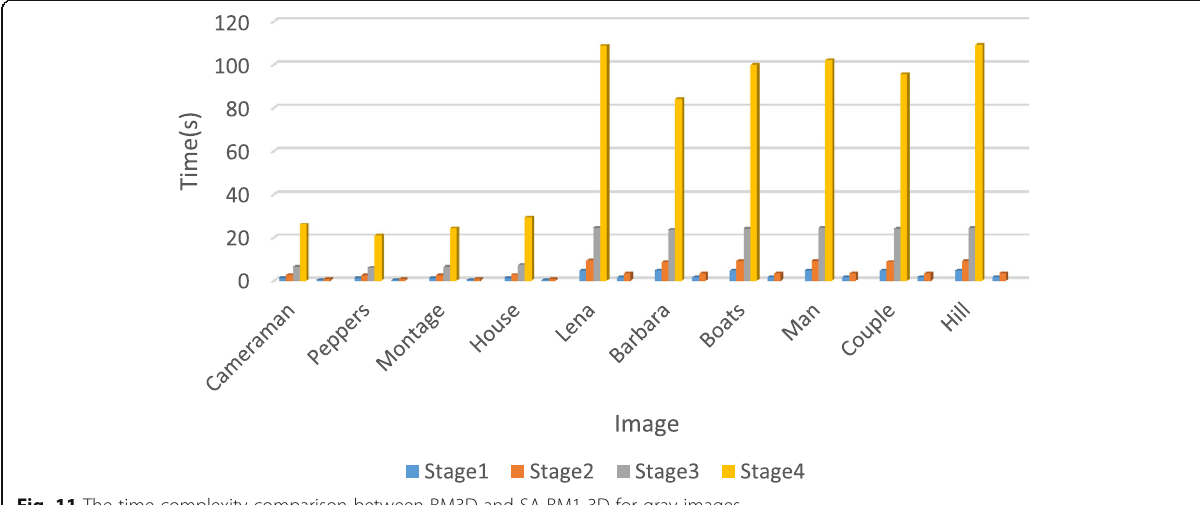
Fig. 11 The time complexity comparison between BM3D and SA-BM1-3D for gray images